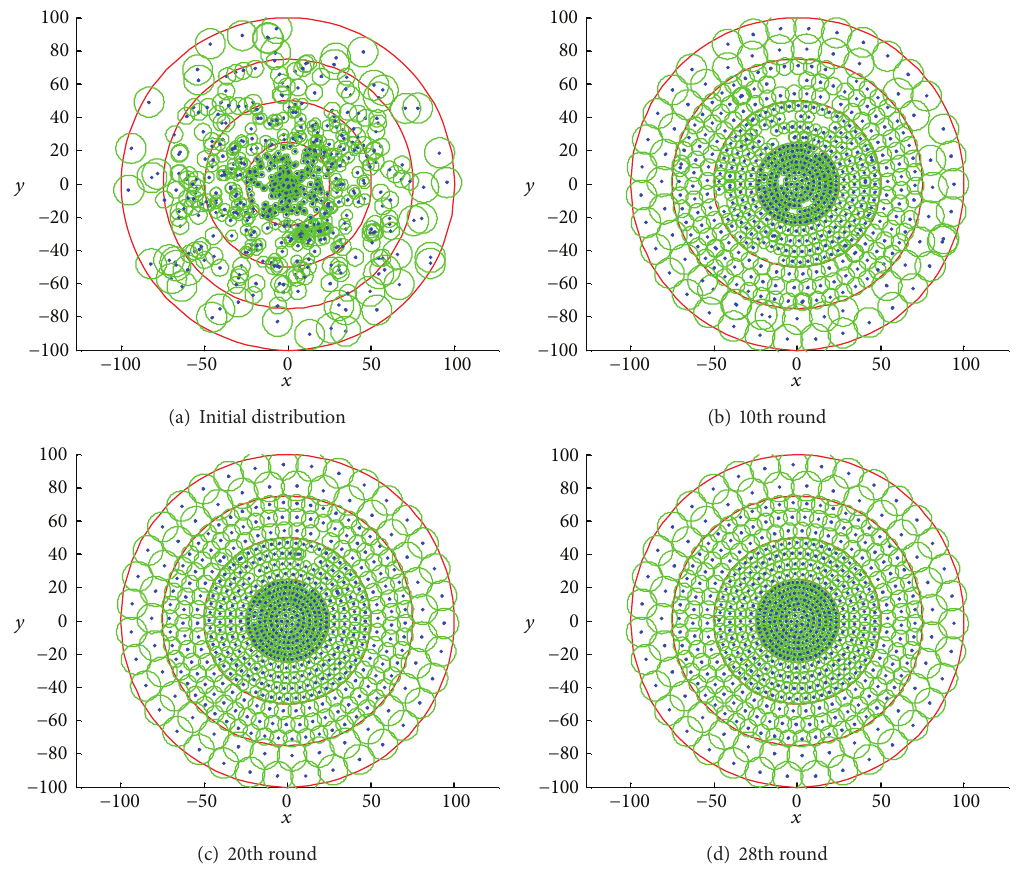
Figure 5: Illustration of network distribution in different rounds using Gaussian deployment model.